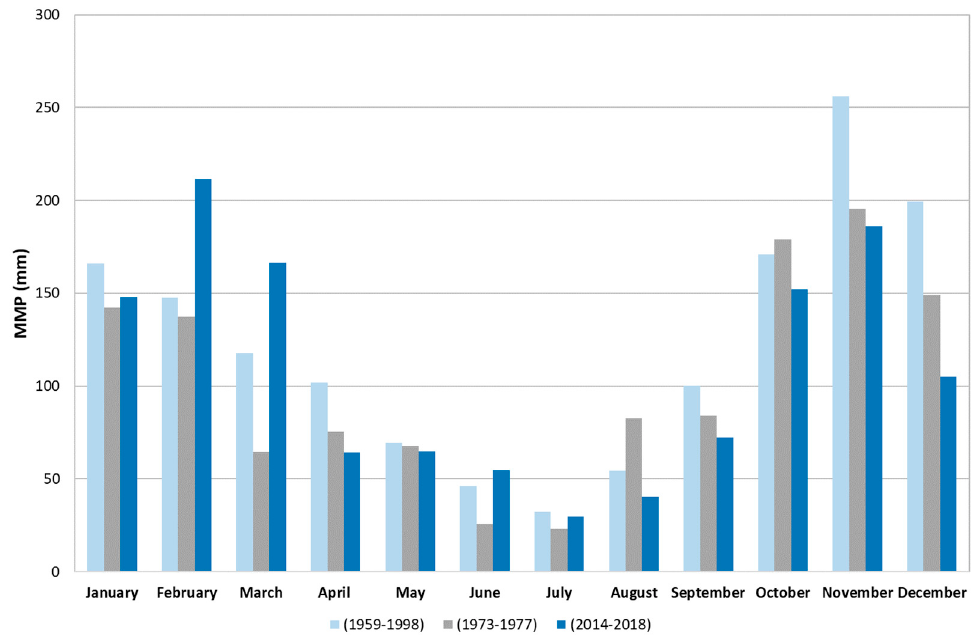
Figure 3. Mean Monthly Precipitation (MMP) seasonal trend in the study area.